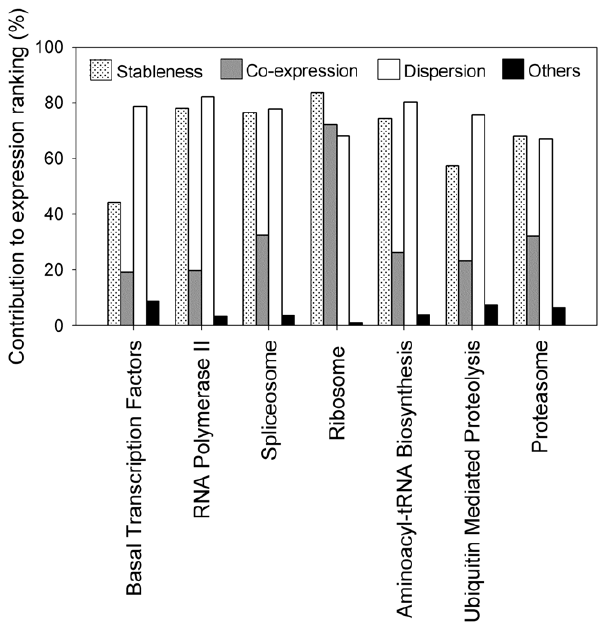
Figure 5. The contributions to the ranking preservation of the HK genes in seven HK-enriched KEGG pathways. Shown is the percentage contribution of the three factors, stableness, co-expression, and dispersion to the expression ranking (Kendall’s tau, (cid:2) tt gg 0 ) computed for the HK genes found in each of the seven HK-enriched KEGG pathways. The black bars are the contributions of other unknown factors.